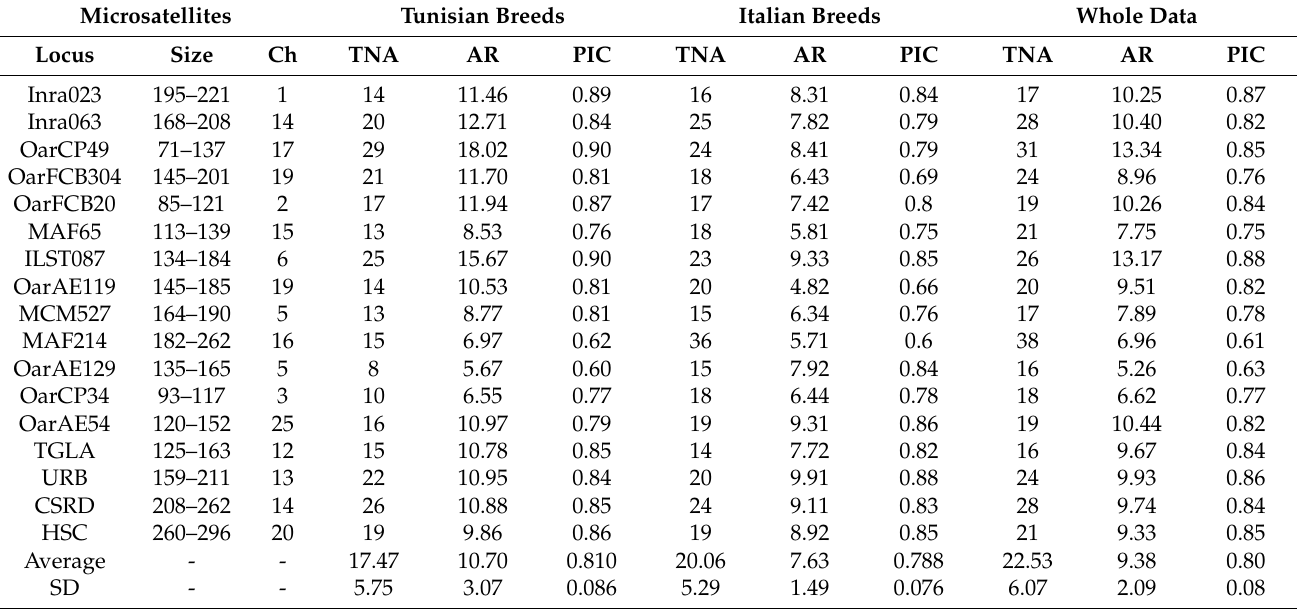
Table 2. Characteristics of the microsatellite loci used to genotype the sampled Tunisian and Italian locally adapted sheep